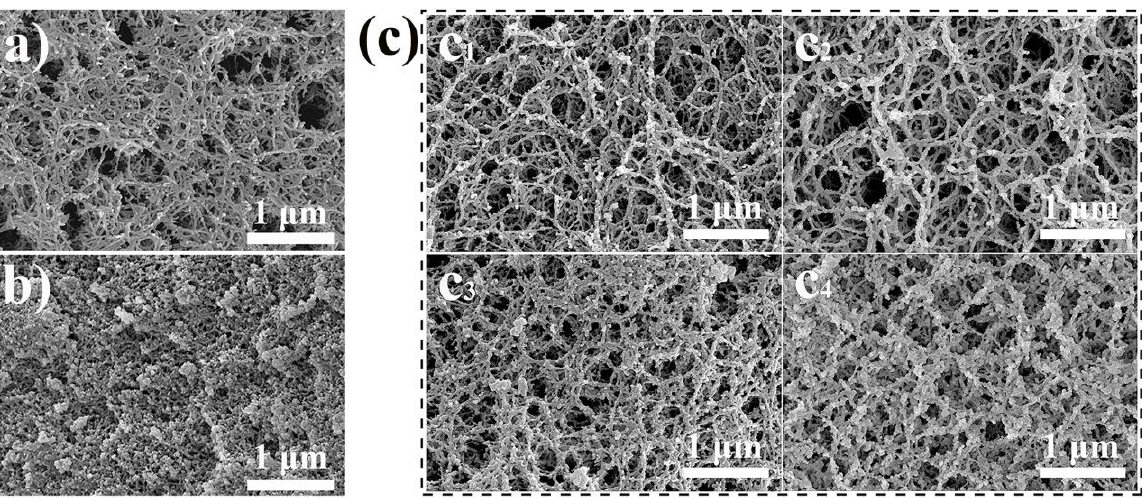
Figure 2. SEM images of AA-2 ( a ) SA-4, ( b ) and CAs ( c ) (CA-1 ( C 1 ), CA-2 ( C 2 ), CA-3 ( C 3 ), and CA-4 ( C 4 ), respectively).